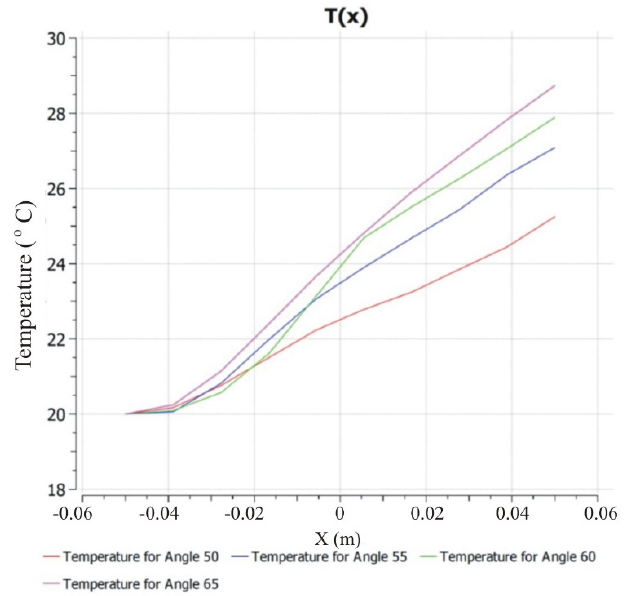
Figure 14. Temperature change graph: red—angle 50°; blue—angle 55°; green—angle 60°; purple—angle 65°.